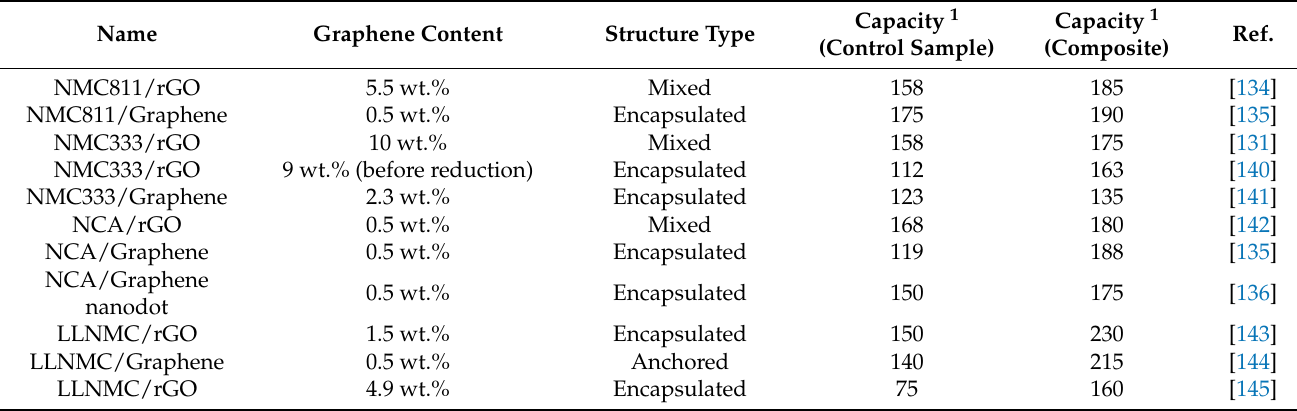
Table 1. The capacities of pristine layered lithium metal oxides and their graphene/rGO composites as cathode materials for Li-ion